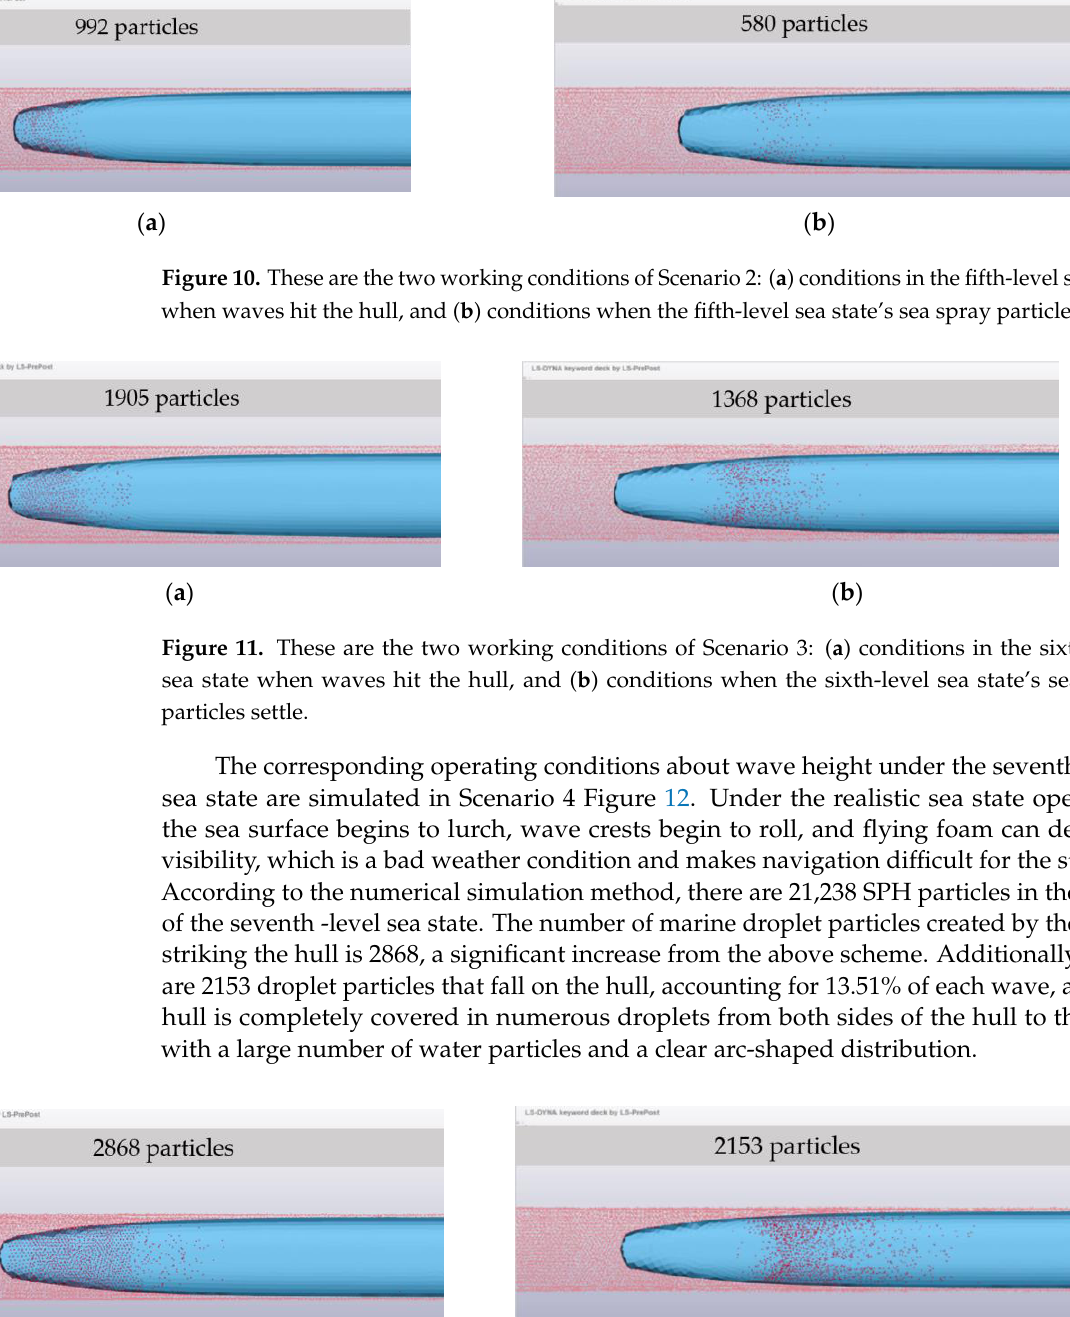
Figure 12. These are the two working conditions of Scheme 4: ( a ) conditions in the seventh-level sea state when waves hit the hull, and ( b ) conditions when the seventh- level sea state’s sea spray par- ticles